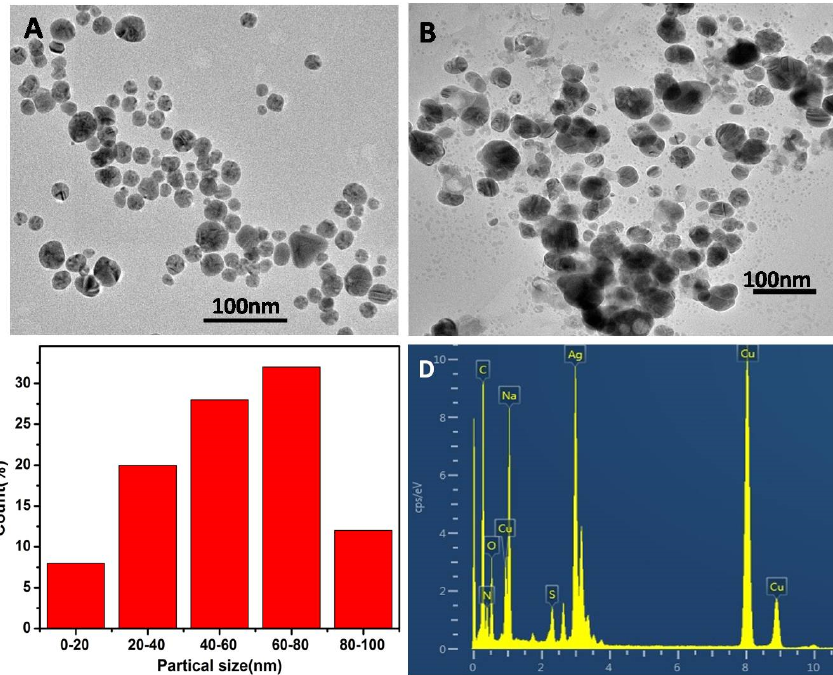
Figure 11. ( A ) TEM of CMS/AgNPs colloidal solution in the presence of SO 42 − and ( B ) S 2 − of 50 μ M, ( C ) size distribution, and ( D ) EDS spectrum of CMS/AgNPs with addition of S 2 − .